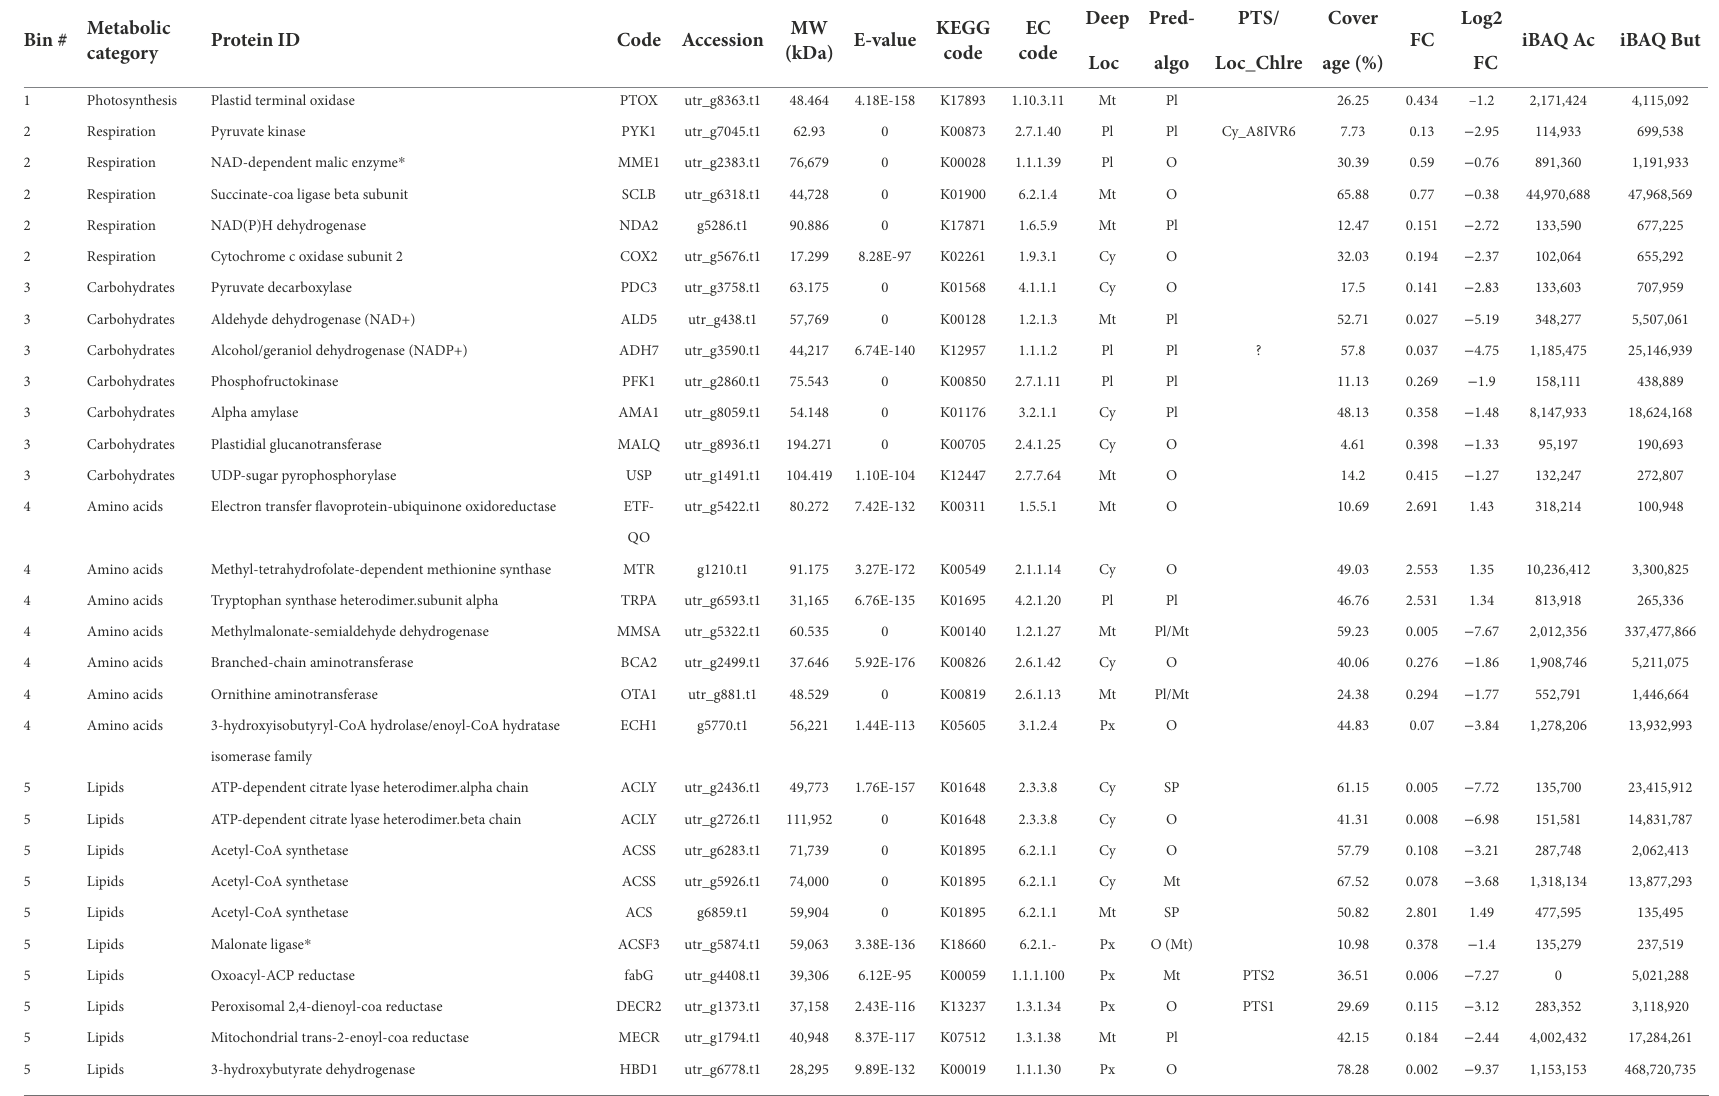
TABLE 1 Overview of the most pertinent proteins with significant FoldChange values arranged by metabolic category as determined by